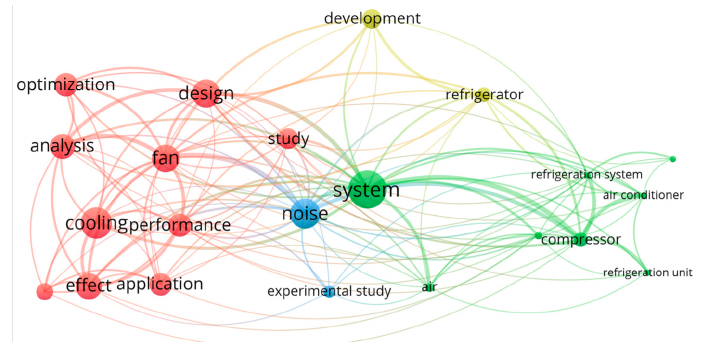
Figure 1. Main topics found about noise in refrigeration using different gases for Web of Science “Core